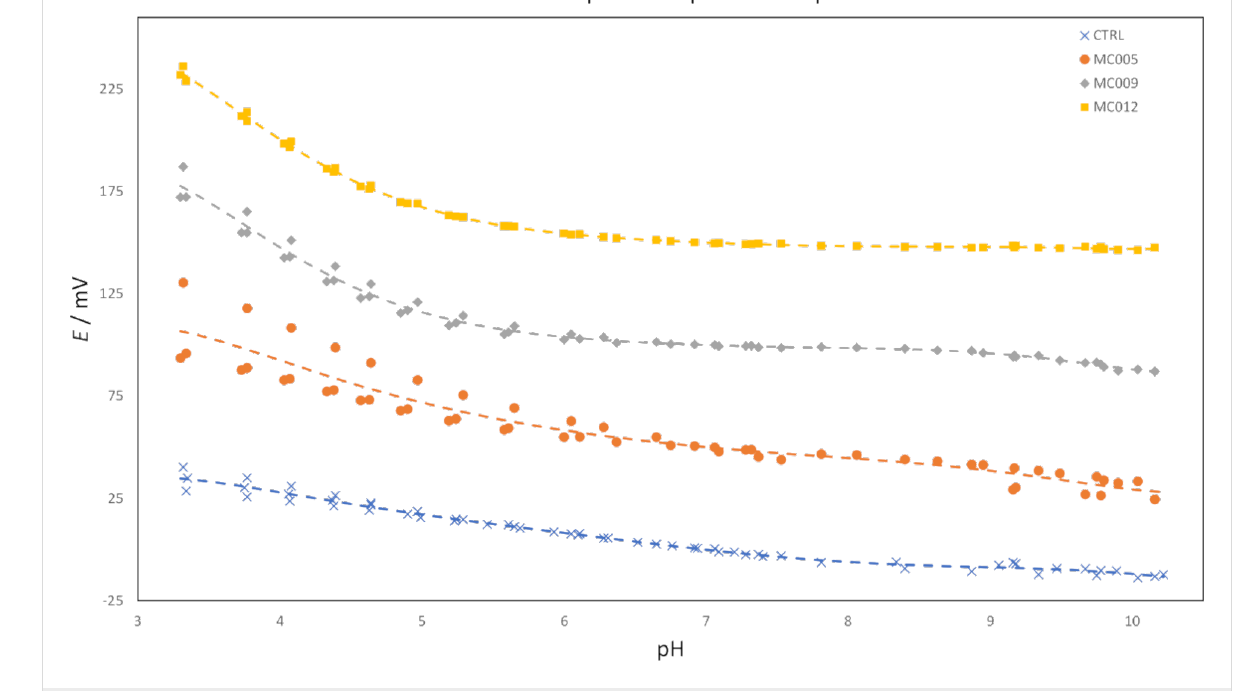
Table 3: Potentiometric selectivity coefficients of interfering anions (relative to acetate) determined using the separate solution method at ambient temperatures. All anions were used as sodium salts. The uncertainties express standard deviations.